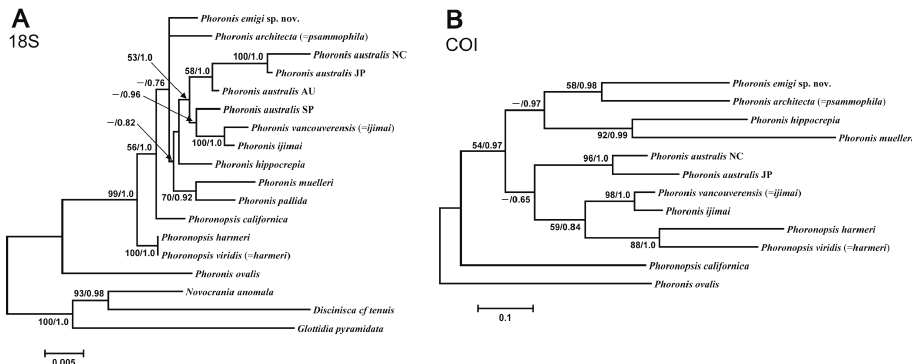
Figure 13. A Maximum-likelihood tree for 15 phoronid samples based on 18S data; three brachiopod species ( Novocrania anomala , Discinisca cf. tenuis , and Glottidia pyramidata ) are included as outgroup taxa B maximum-likelihood tree for 12 phoronid samples based on COI data; the tree is rooted with Phoronis ovalis . The scale bars indicate branch length in substitutions per site. Nodal support values are presented as the ML bootstrap value followed by the Bayesian posterior probability; only values >50% and 0.50, respectively, are